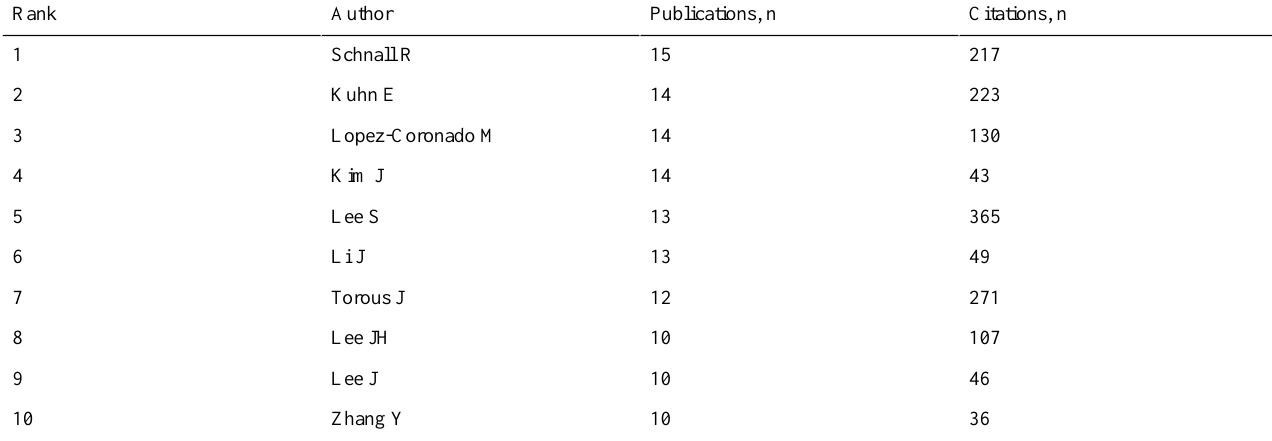
Table 3. Top 10 most productive authors in mobile health app research,